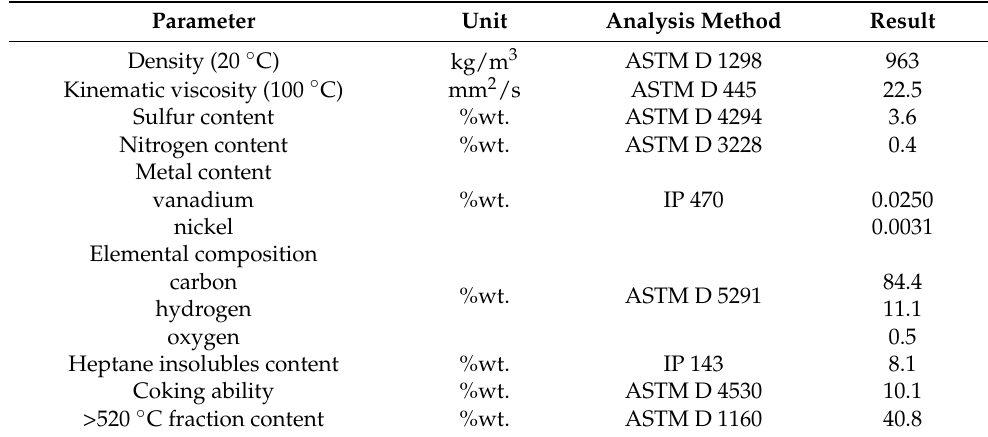
Figure 7. Scheme of high-pressure flow unit (1, 11—flow controller, 2—reservoir for feed emulsion, 3, 8, 9—filter and absorbers, 4—feed pump, 5—hydroconversion reactor, 6, 7—high-pressure and low-pressure separators, 10—gas-drying adsorber, 12—emulsion preparation section). Table 7. Properties of the bituminous oil.